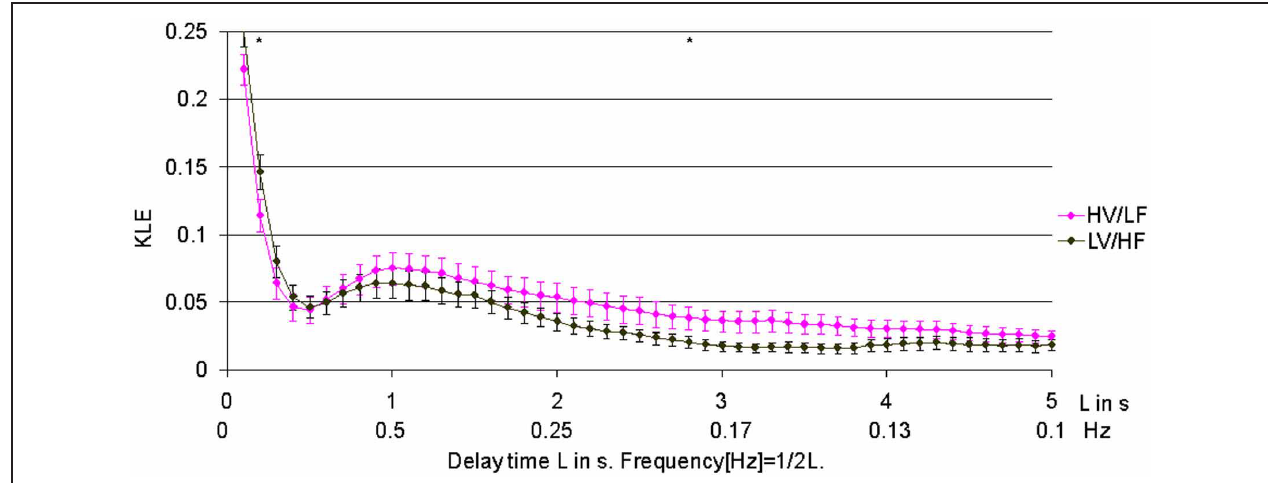
FIGURE 3 | Relationship of HV/LF and LV/HF electrocortical state activities to the time scales of fHRV complexity. KLE complexity of fetal heart rate variability (fHRV) measured during high voltage/low